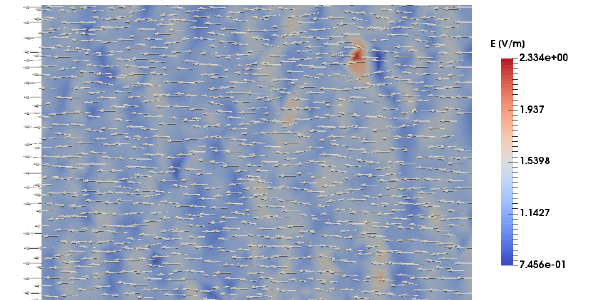
Figure 4: Result of single forward simulation of electric field inside a potato with random conductivity